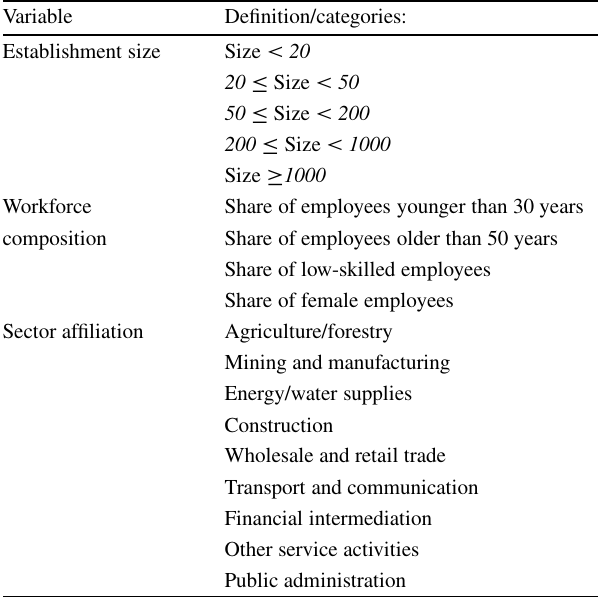
Table 14 Definition of establishment characteristics gained from the Employment Statistics Register Variable